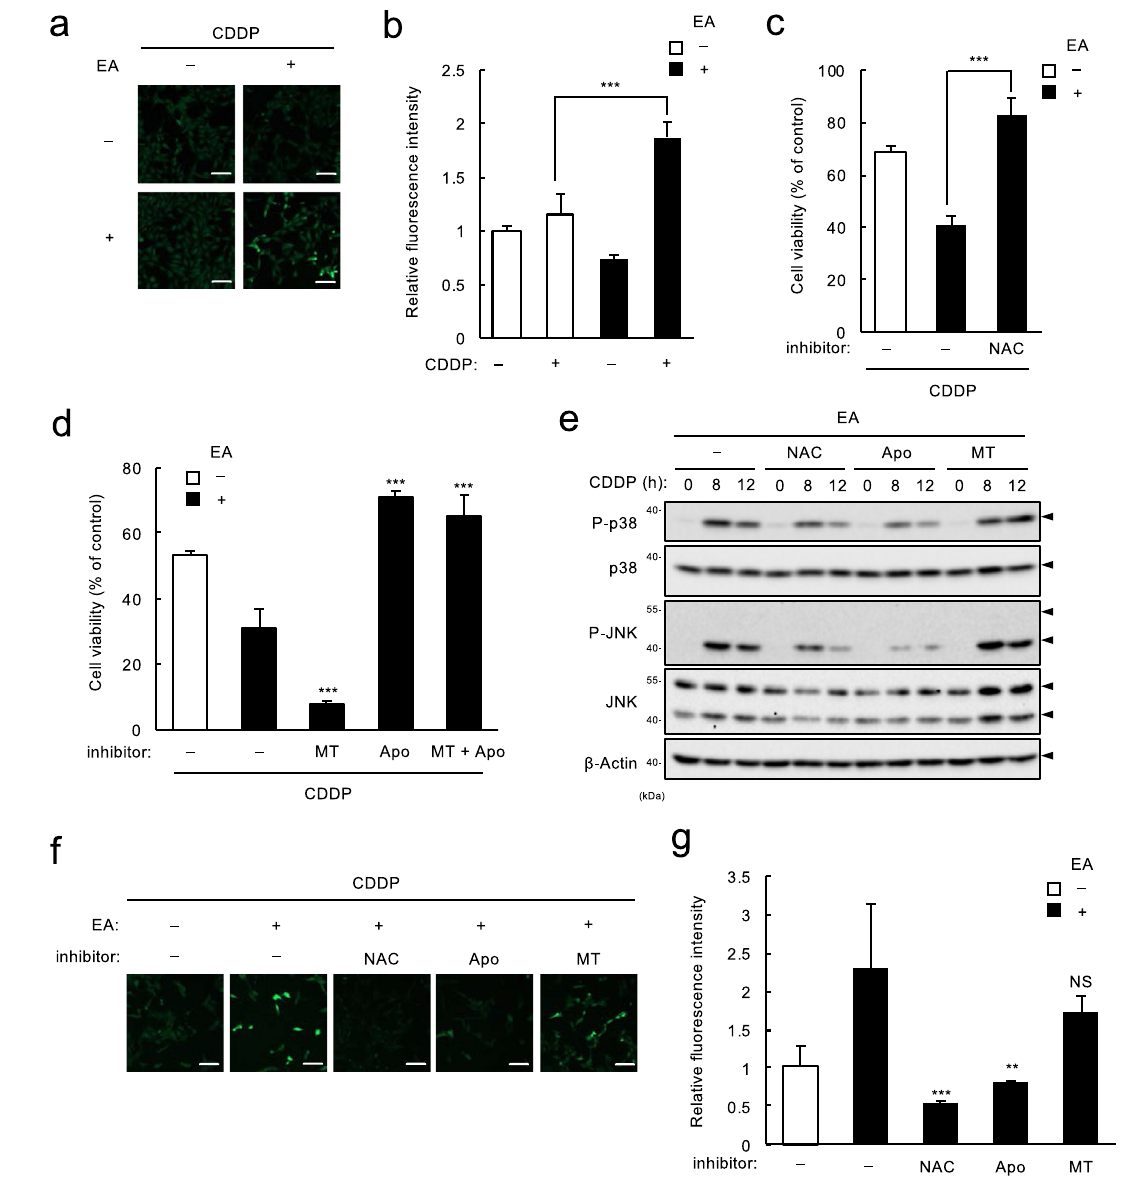
Figure 4. EA promotes CDDP-induced cell death through enhancement of ROS generation by NADPH oxidase. ( a and b ) U2OS cells were pretreated 200 µM EA for 12 h, and then stimulated with 40 μM CDDP for 9 h, followed by incorporation of a ROS-sensitive fluorescent probe DCFH-DA for 30 min. Green fluorescence was observed by confocal microscope ( a ), and relative ROS levels were calculated, shown as mean ± SD (n = 3, normalized to the ROS level in the cells without fatty acid and CDDP) ( b ). Scale bar, 100 µm. ( c ) U2OS cells were pretreated with or without 200 µM EA for 11.5 h, treated with antioxidant N-acetylcysteine (NAC, 1 mM) for 0.5 h, and then stimulated with 40 μM CDDP for 24 h, subjected to cell viability assay. Data shown are the mean ± SD (n = 3). ( d ) U2OS cells were pretreated with 200 μM EA for 11.5 h, treated with either mito-Tempo (MT, 10 μM) or Apocynin (Apo, 100 μM) alone or together for 0.5 h, and then stimulated with 40 μM CDDP for 24 h, subjected to cell viability assay. Data shown are the mean ± SD (n = 3). *** p < 0.001 (vs. EA-pretreated cells without any inhibitor). ( e ) U2OS cells were pretreated with 200 μM EA for 11.5 h, treated with either 1 mM NAC, 100 μM Apo and 10 μM MT for 0.5 h, and then stimulated with 40 μM CDDP for the indicated time periods. Cell lysates were subjected to immunoblotting with the indicated antibodies. ( f and g ) U2OS cells were pretreated with or without 200 µM EA for 12 h, and then stimulated with 40 μM CDDP for 6 h, followed by incorporation of a ROS-sensitive fluorescent probe DCFH-DA for 30 min. Green fluorescence was observed ( f ) and relative ROS levels were calculated ( g ), shown as mean ± SD (n = 3, normalized to the ROS level in the cells without fatty acid and CDDP). Scale bar, 100 µm. ** p < 0.01; *** p <